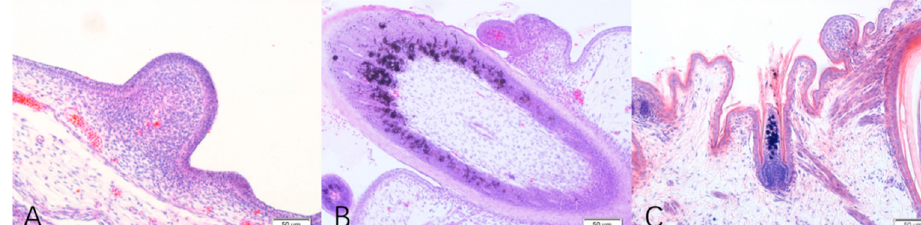
Figure 4. Microscopic observation of geese embryo skin at three different developmental stages by HE. Note: ( A ) primordial period of primary feather follicles at embryonic day 13, ( B ) primordial period of secondary feather follicles at embryonic day 18, and ( C ) greater developmental period of secondary feather follicles at embryonic day 28. Magnified: 10×; Bar: 100 μ m.